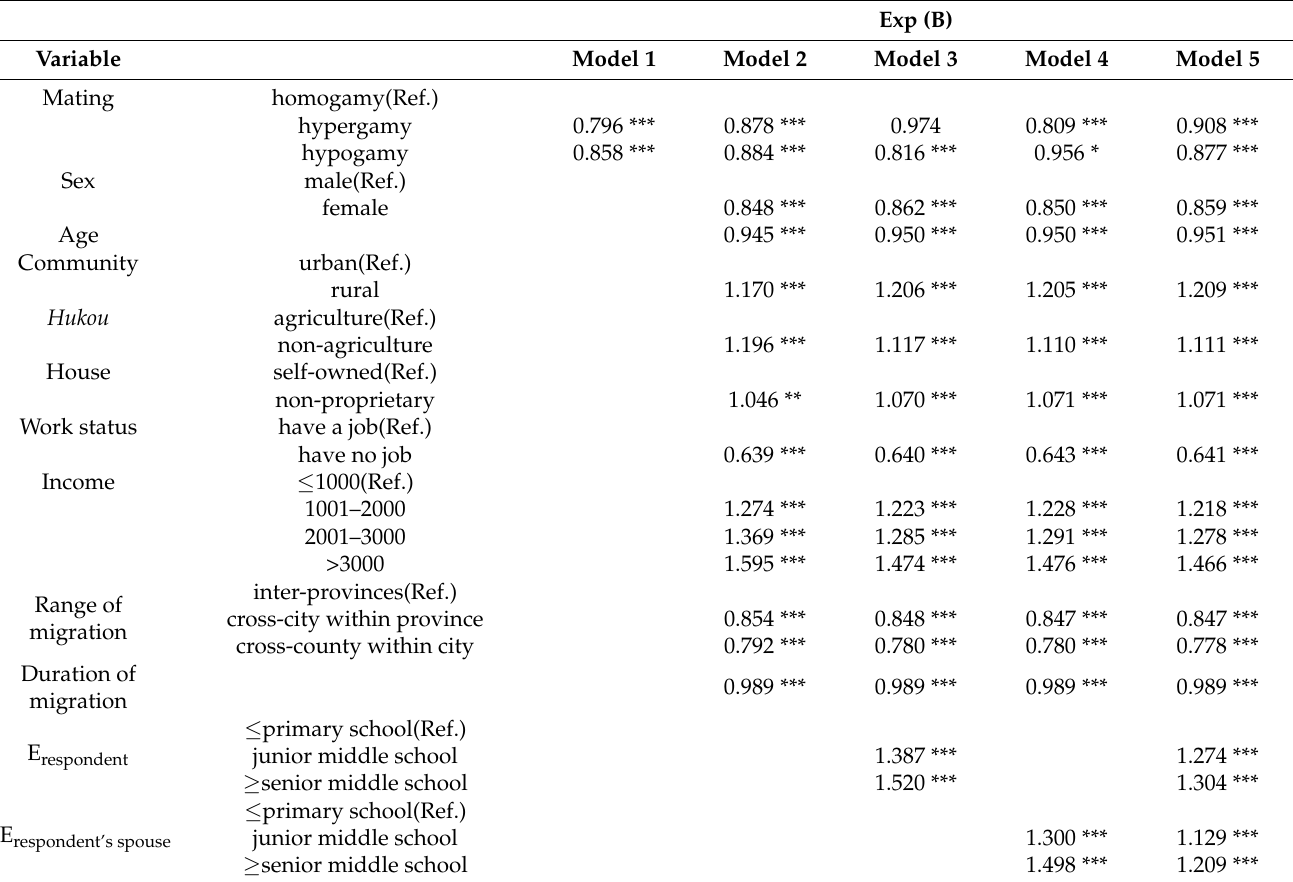
Table 5. Influencing factors of internal migrants’ SRH (N = 127,829).